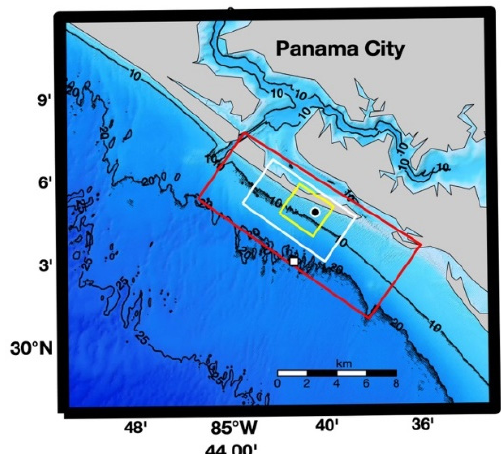
Figure 6. Study area with bathymetry, depth contours (10 m, 20 m, and 25 m), and computational grids for wave module (red), flow module with coarse resolution (white), and flow module with fine resolution (yellow). The black dot represents the shallow quadpod location, and the white square denotes the deep quadpod location (from [17]).